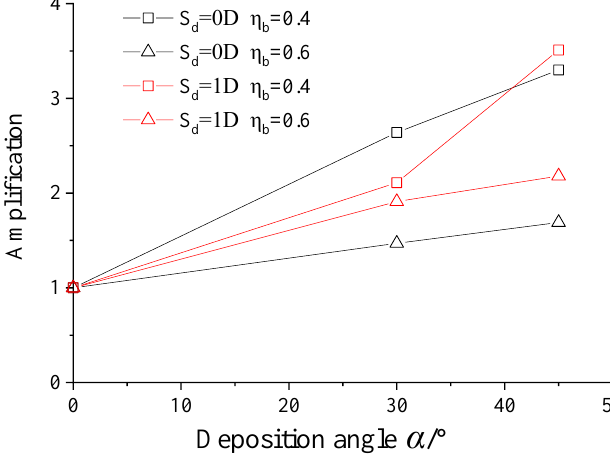
Figure 14. Amplification of the cumulative displacement with deposition angle.